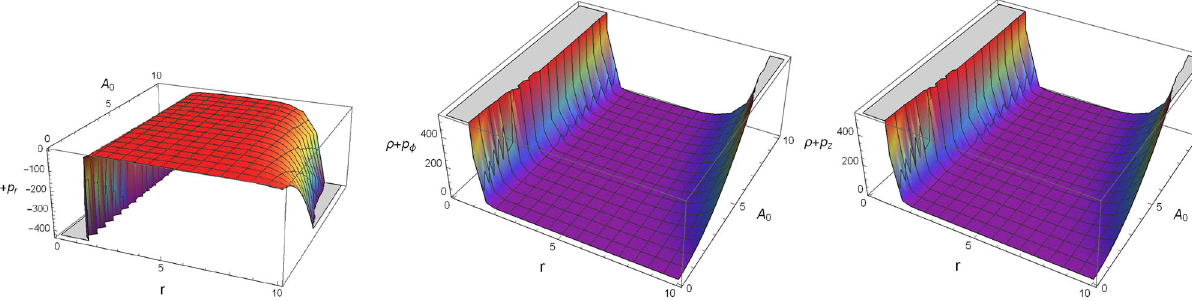
Fig. 10 This panel shows the variation of (ρ + p r ) (MeV/fm 3 ) , (ρ + p φ ) (MeV/fm 3 ) and (ρ + p z ) (MeV/fm 3 ) w.r.t r (km) and A 0 parameter with m = n = 1. CASE (C)